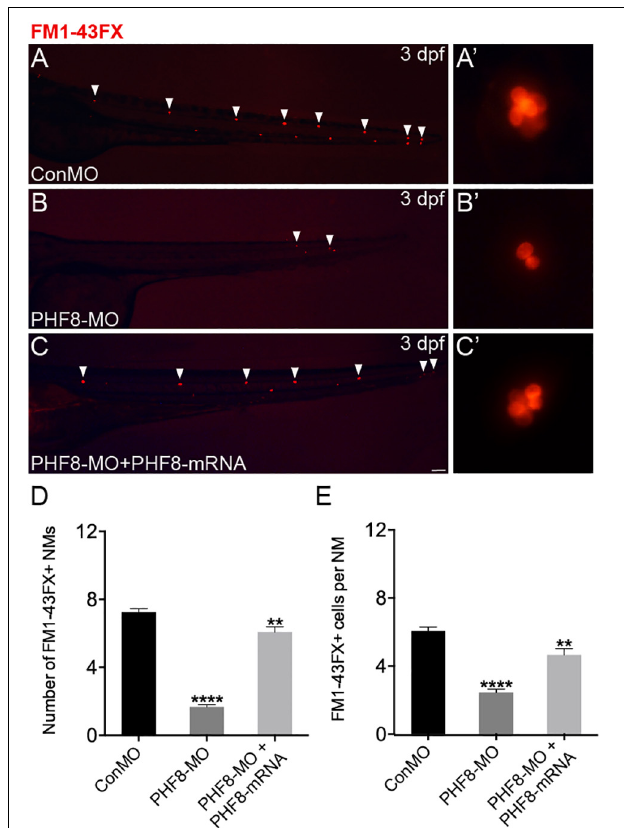
FIGURE 3 | Analysis of neuromast hair cells in PHF8 morphant. (A–C) Embryos from different groups were stained with FM1-43FX at 3 dpf to detect functional neuromasts. (A’–C’) The enlarged FM1-43FX-positive neuromasts in controls (A’) , PHF8 morphants (B’) , and PHF8-MO co-injected with PHF8-mRNA embryos (C’) at 3 dpf. (D) The average number of FM1-43FX-positive neuromasts in controls (ConMO; n = 12 embryos), PHF8 morphants (PHF8-MO; n = 12 embryos), and PHF8-MO co-injected with PHF8-mRNA embryos (PHF8-MO + PHF8-mRNA; n = 12 embryos) at 3 dpf. (E) The average number of FM1-43FX-positive cells per neuromast (NM) in controls (ConMO; n = 20 neuromasts), PHF8 morphants (PHF8-MO; n = 20 neuromasts), and PHF8-MO co-injected with PHF8-mRNA embryos (PHF8-MO + PHF8-mRNA; n = 20 neuromasts) at 3 dpf. White arrowheads implicate the locations of the neuromasts on one side. ** p < 0.01, **** p < 0.0001 vs. the ConMO group. Data are presented as means ± SEM. All pictures showed lateral view, anterior left. Scale bar, 100 µ m. Neuromast,